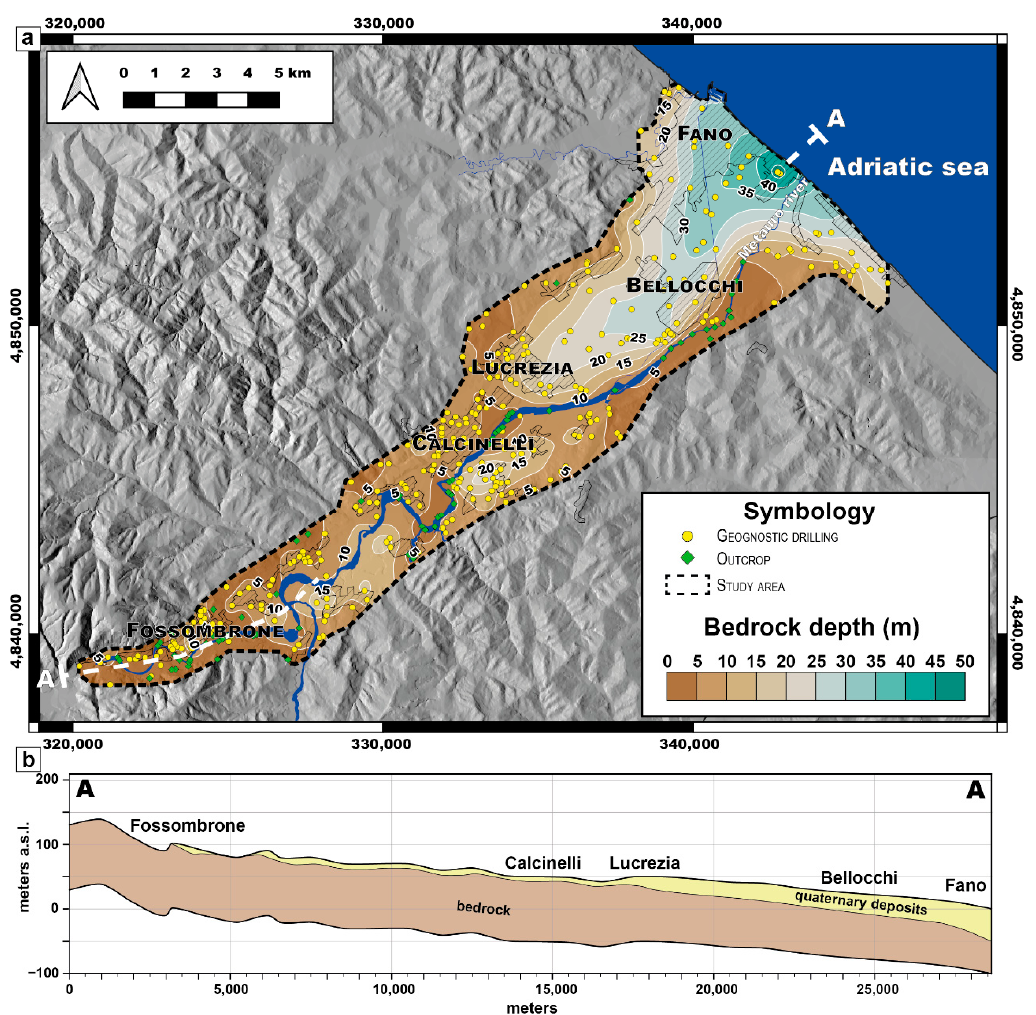
Figure 3. ( a ) Bedrock depth and location of the geognostic drillings and outcrops; ( b ) topographic profile (exaggerated vertical scale) and schematic relationship between the sedimentary bedrock and the alluvial Quaternary deposits along the Metauro Valley. The total thickness considered is 100 m.